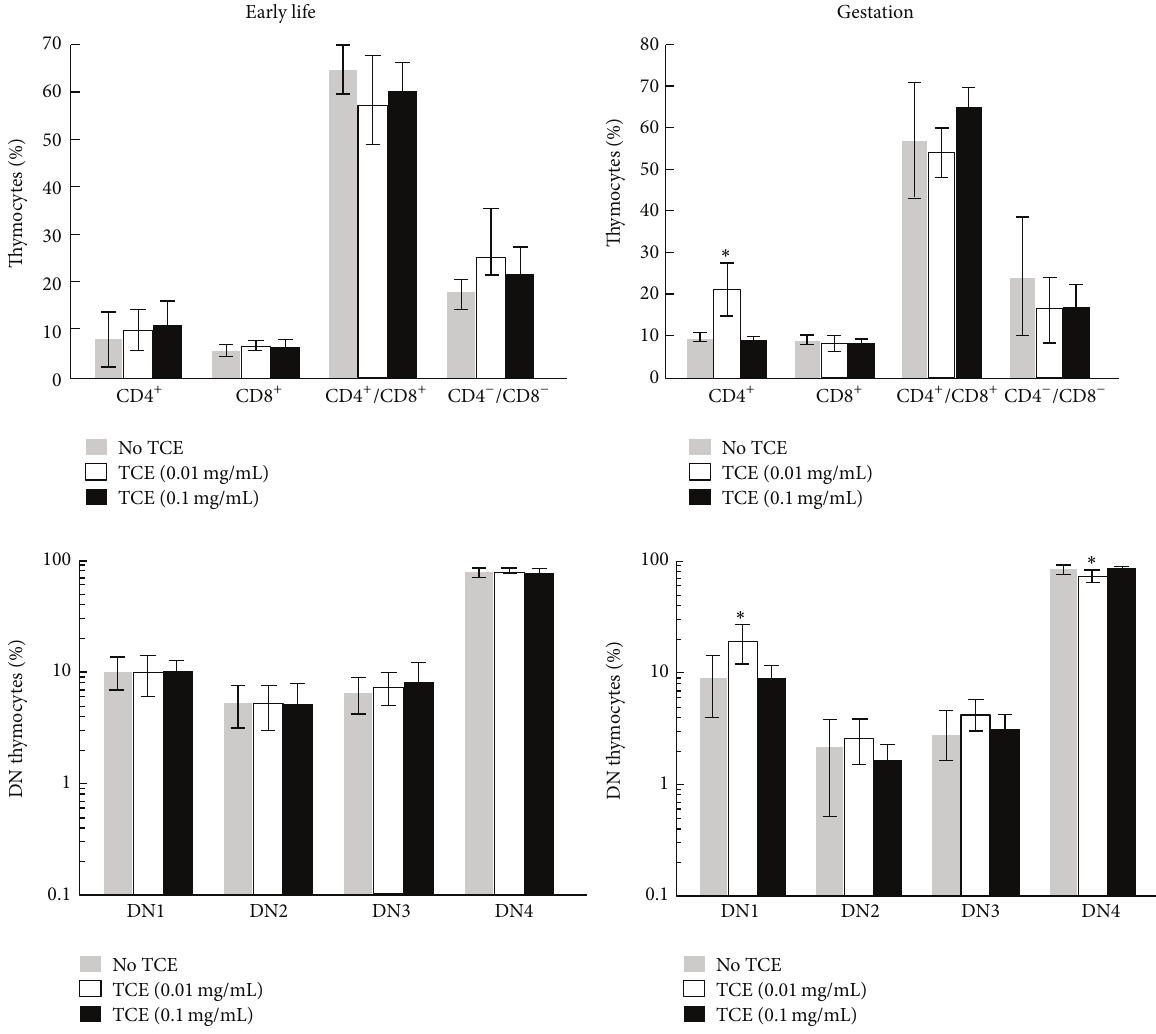
Figure 5: TCE altered thymus cellularity in mice exposed to TCE during gestation. Thymocyte suspensions from PND49 mice that had been exposed to TCE during gestation only or during early life only were incubated for 18 hours and then examined by flow cytometry to determine the percentage of single positive, double negative, and double positive cells. In addition, after gating on the double negative cell population, the cells were stained with anti-CD44 and anti-CD25 Abs and labeled as DN1 (CD44 + CD25 − ), DN2 (CD44 + CD25 + ), DN3 (CD44 − CD25 + ), and DN4 (CD44 − CD25 − ). ∗ Significantly different ( 𝛼 < 0.05 ) compared to control